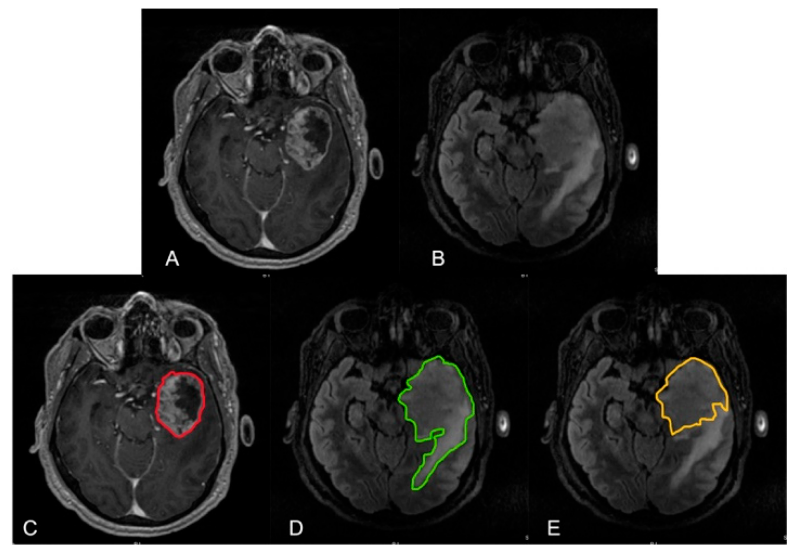
Figure 2. Preoperative magnetic resonance imaging highlighting left temporal lobe glioblastoma. ( A ) T1 post-contrast MRI. ( B ) T2 FLAIR MRI. ( C ) Red line highlighting contrast-enhancing tumor. ( D ) Green line demonstrating extent of tumor associated FLAIR. ( E ) Gold line outlining potential extent of non-contrast enhancing tumor or mass-like FLAIR signal.